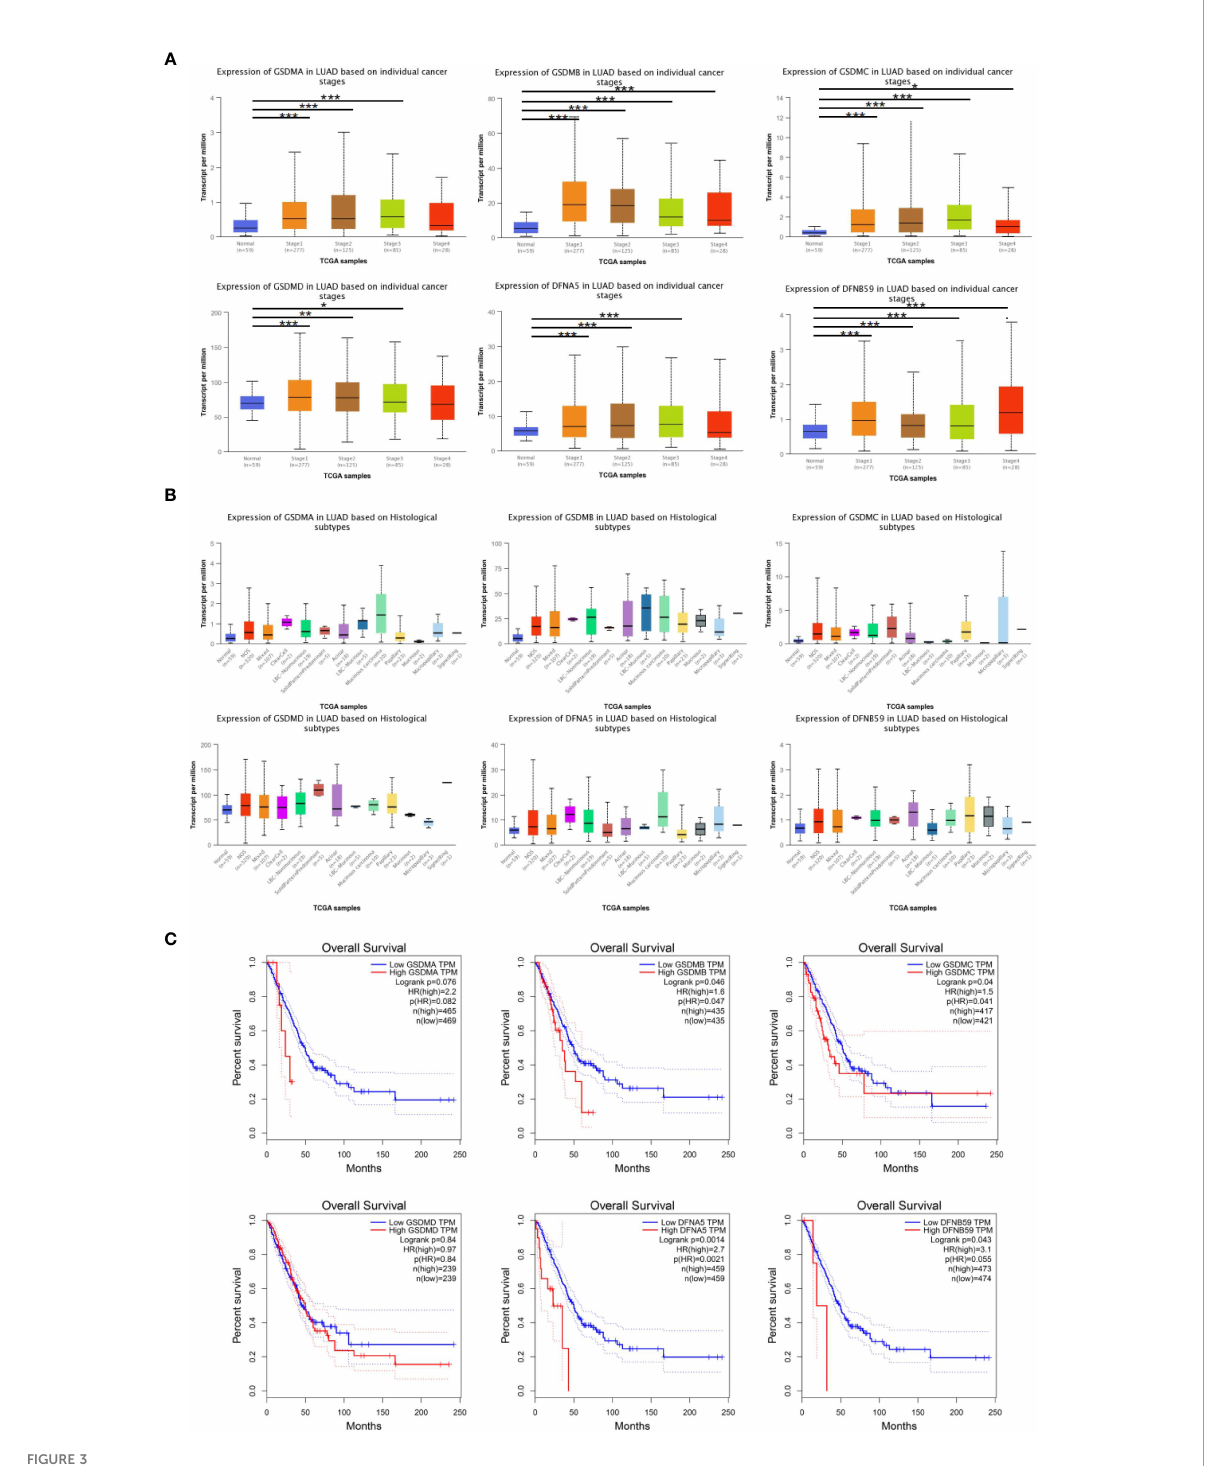
FIGURE 3 GSDMs family member-associated clinical pathology characteristics of patients with LUAD. (A) The associations between GSDM transcript levels and individual cancer stages of LUAD. (B) The expression of GSDM family members in different LUAD histological subtypes. (C) The GEPIA database was used to analyze the relationships between GSDM transcript levels and OS of LUAD patients. * means p<0.05, ** means p<0.005, and *** means